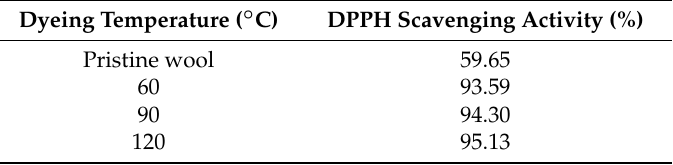
Table 7. Antioxidant ability of wool fabrics dyed with spent coffee extract for 60 min as a function of dyeing temperature (all dying samples were mordanted with 1 wt % tannic acid aqueous